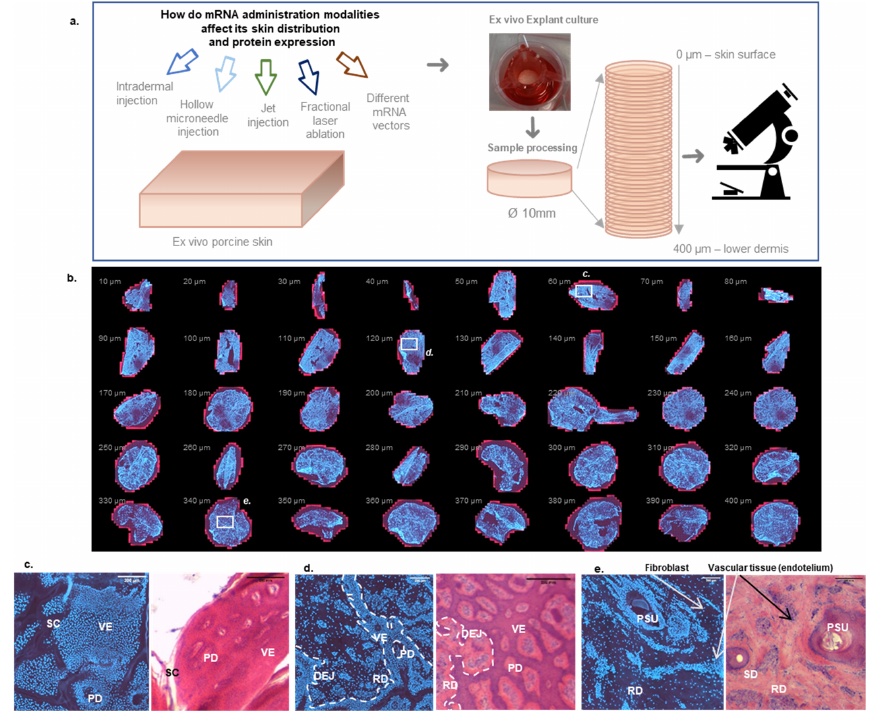
Figure 1. Histological characterization of skin horizontal sections. ( a ) Experimental Workflow: each sample that underwent mRNA ex vivo delivery was horizontally cryotomed into 40 slices of 10 µm thickness prior to microscopic observation. ( b ) Montage of all 40 DAPI-stained skin sections after FM observation (Ø10 mm; untreated skin): Cy5 background signal (red) and DAPI signal (blue), each sample in the montage has a 10 mm diameter. Magnified slices when stained with DAPI and with H&E: ( c ) Comparative histology of slice 6; 60 µm depth—viable epidermis. ( d ) Comparative histology of slice 12; 120 µm depth—at the dermo-epidermal junction. ( e ) Comparative histology slice 34; 340 µm depth—deep reticular dermis. Scale bar ( c – e ): 200 µm. Annotations: SC: Stratum corneum, VE: viable epidermis PD: papillary dermis DEJ: Dermo-epithelial junction RD: Reticular dermis PSU: pilosebaceous unit SD: sweat duct. Individual Fibroblasts and vascular endothelial tis- sue could also be observed. 3.2. Effect of Different Delivery Techniques on Skin Distribution of Cy5 Labeled mRNA and eGFP Expression Images obtained by the combination of all DAPI stained sections after the delivery of Cy5 labeled mRNA and eGFP expression using different formulations and delivery tech- niques were compared. All montage images are composed of 5 rows and 8 columns start- ing with section 1 (“nominal” depth going from skin surface to10 µm) in the upper left and finishing by section 40 (“nominal” depth going from 390 to 400 µm) in the lower right. The scale is not indicated as each section has a diameter of 10 mm. All missing or compro- mised sections have been replaced by the black background to keep the section numbering